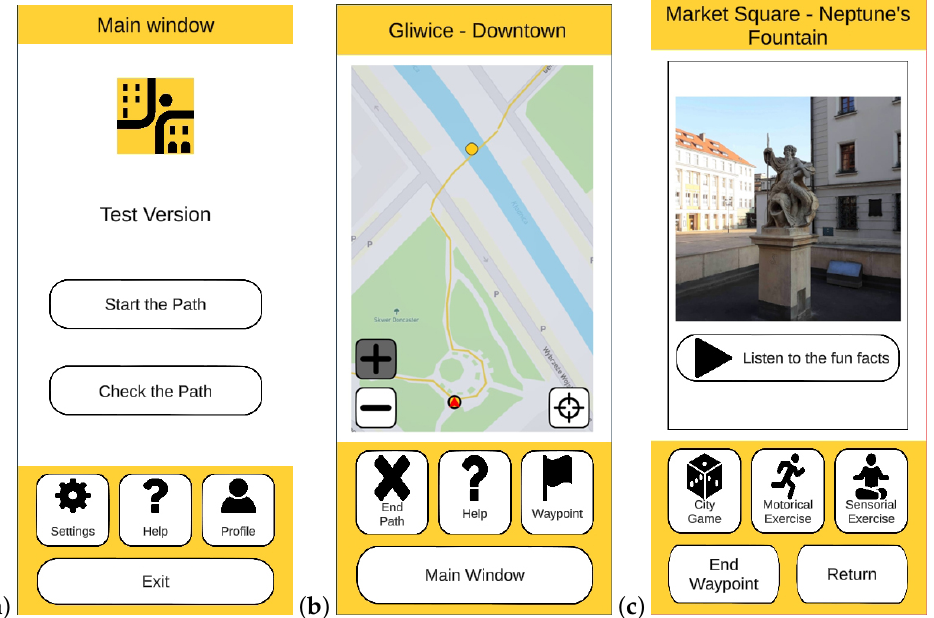
Figure 1. Screenshots from the mobile application Urban Health Path: ( a ) Main window, ( b ) Path window (an example), ( c ) Waypoint window (an